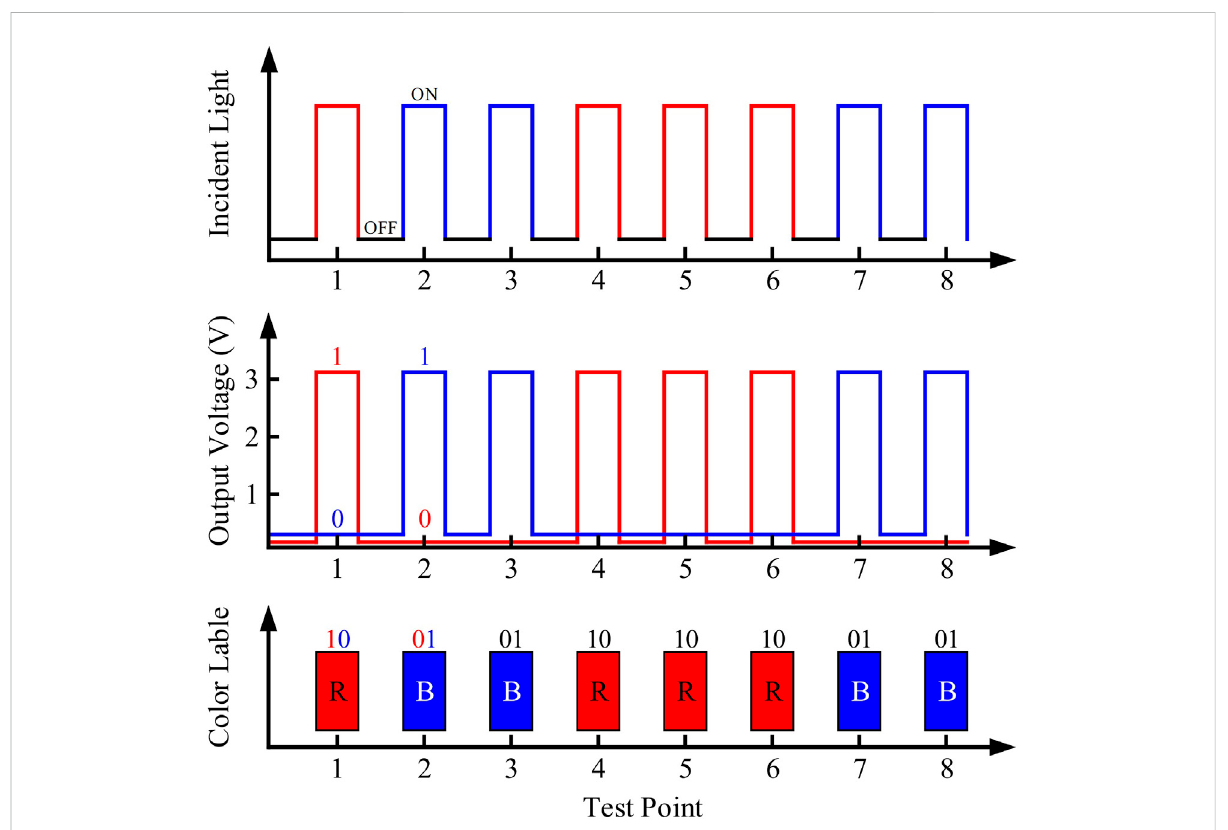
FIGURE 8 The steady-state optical measurements of the proposed receiver. The receiver is able to accurately recognize the blue and red light, and the corresponding outputs can be used as the color label of the visible